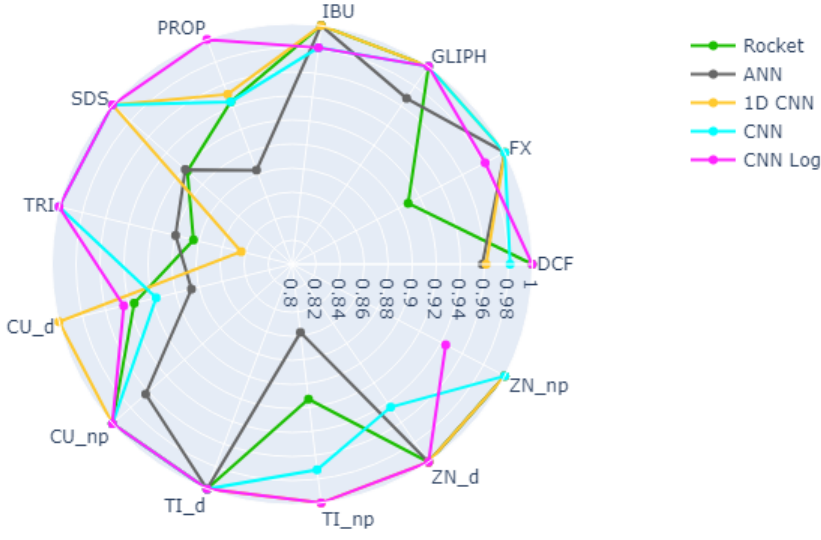
Figure 4. Spider plot depicting the accuracy per class of each best performing model when predicting the different types of